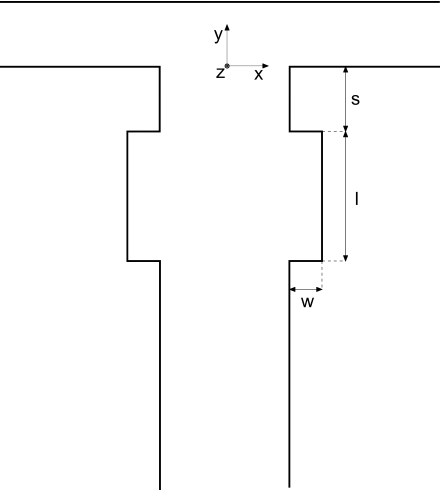
Figure 1. Sketch of the